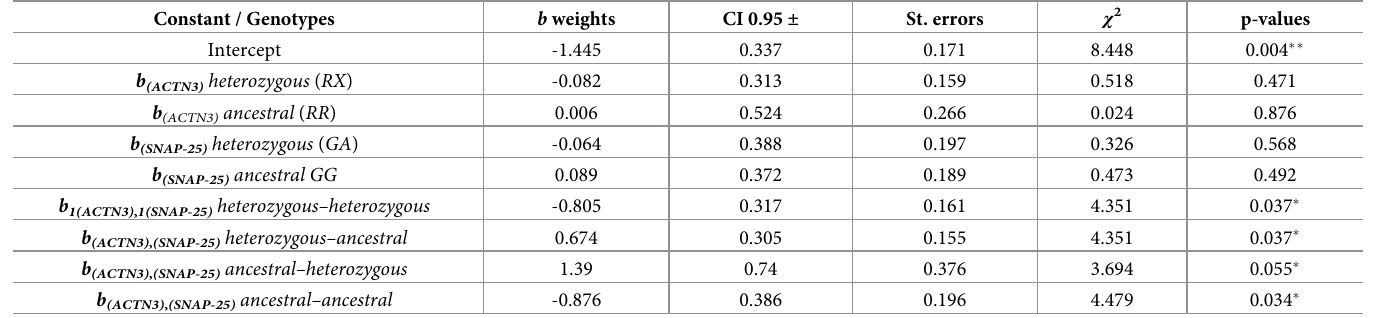
Table 4. The full ACTN3 –SNAP-25 model with the derived allele reference